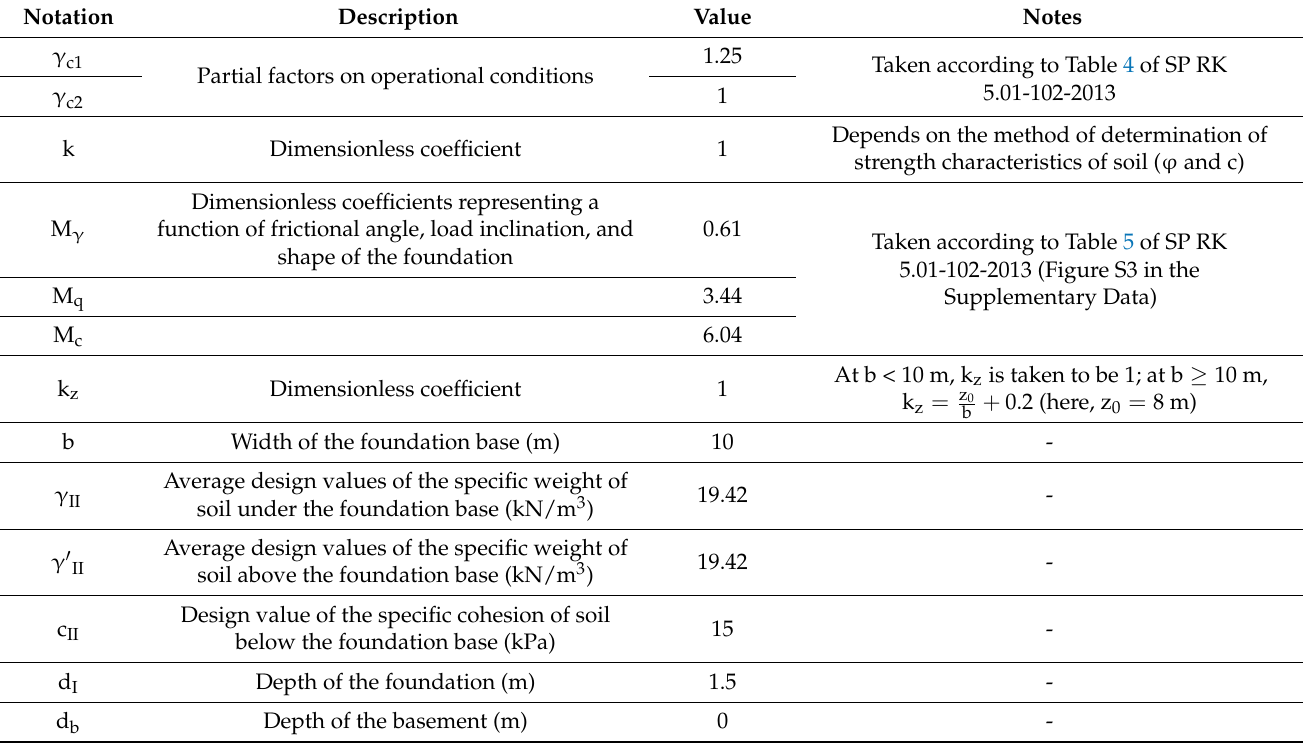
Table 5. Description of parameters in SP RK 5.01-102-2013—Foundations of buildings and